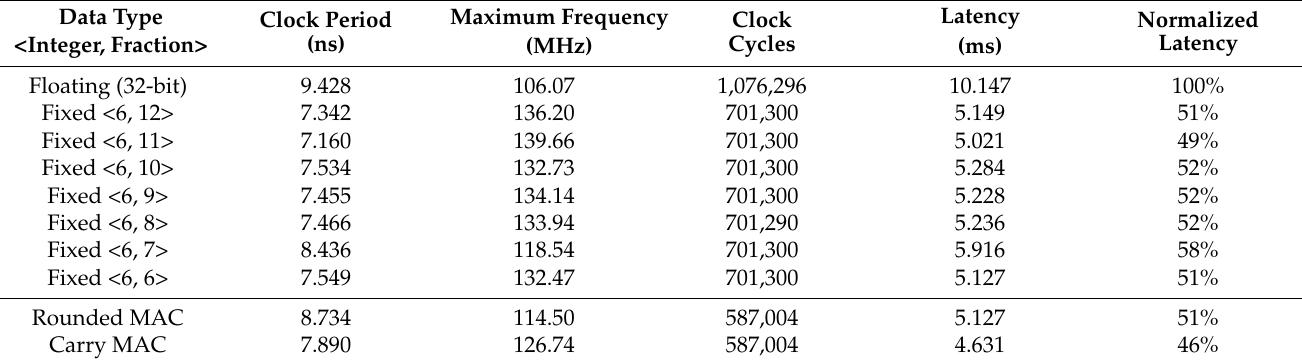
Table 4. Timing comparisons between accelerator models.